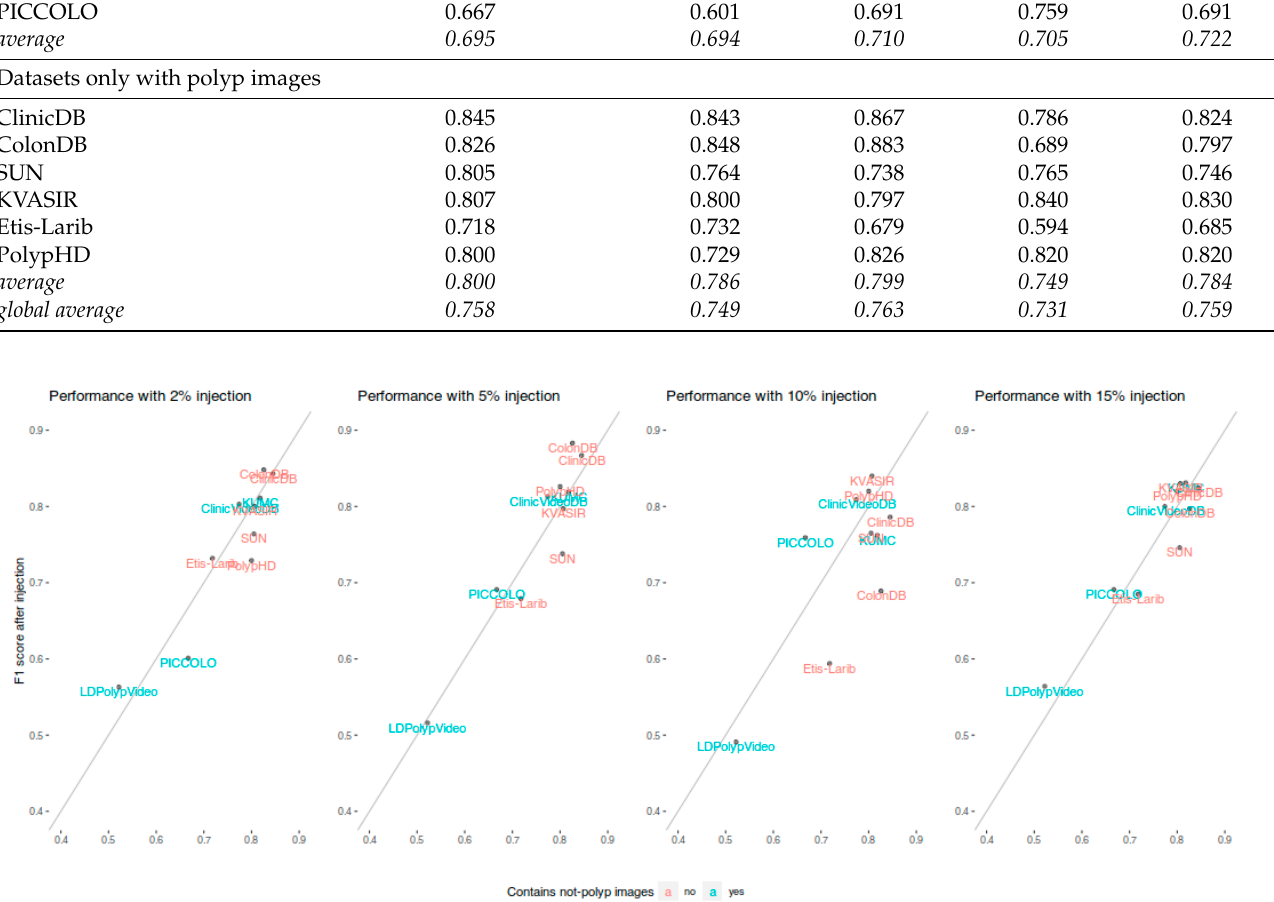
the original average of 0.800.